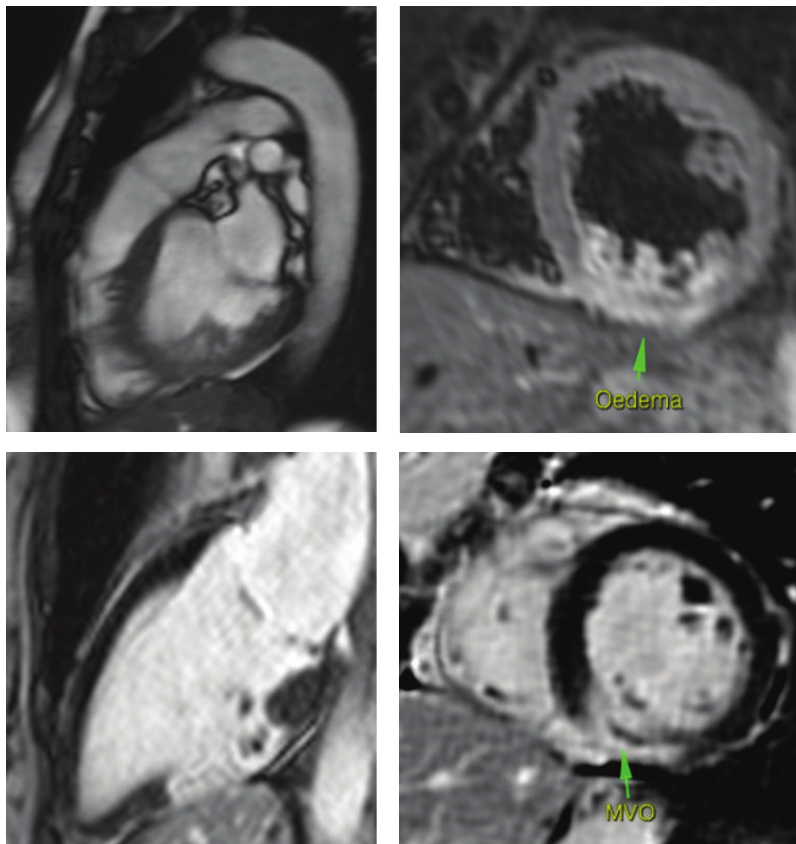
Figure 2: CMR assessment. Comment: 51-year-old female following an inferior ST segment elevation myocardial infarction. CMR revealed hyperintensity in the midinferior wall on T2 weighted images. There is 100% transmural late gadolinium enhancement of the midinferior wall indicating nonviability of this region of myocardium. Of note, an area of hypoenhancement is also present in the middle of the hyperenhancement region, indicating microvascular obstruction. There is also late gadolinium enhancement affecting part of the posterior papillary